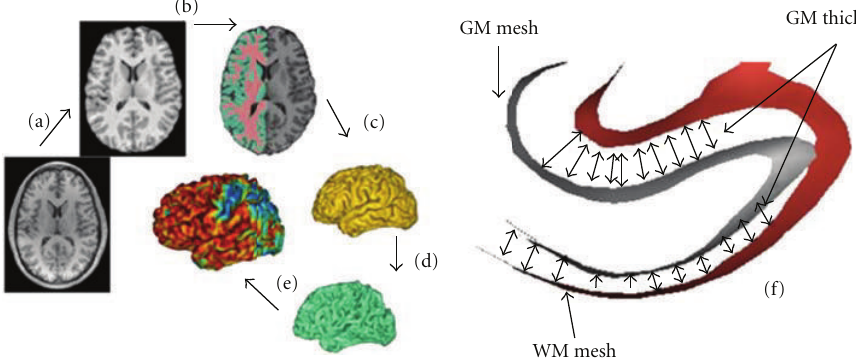
Figure 1: T 1 -weighted image processing pipeline consists of (a) skull stripping; (b) spatial normalization, RF homogeneity correction, and tissue segmentation; (c, d) extraction of GM and WM pial surfaces; (e, f) calculation of GMT.